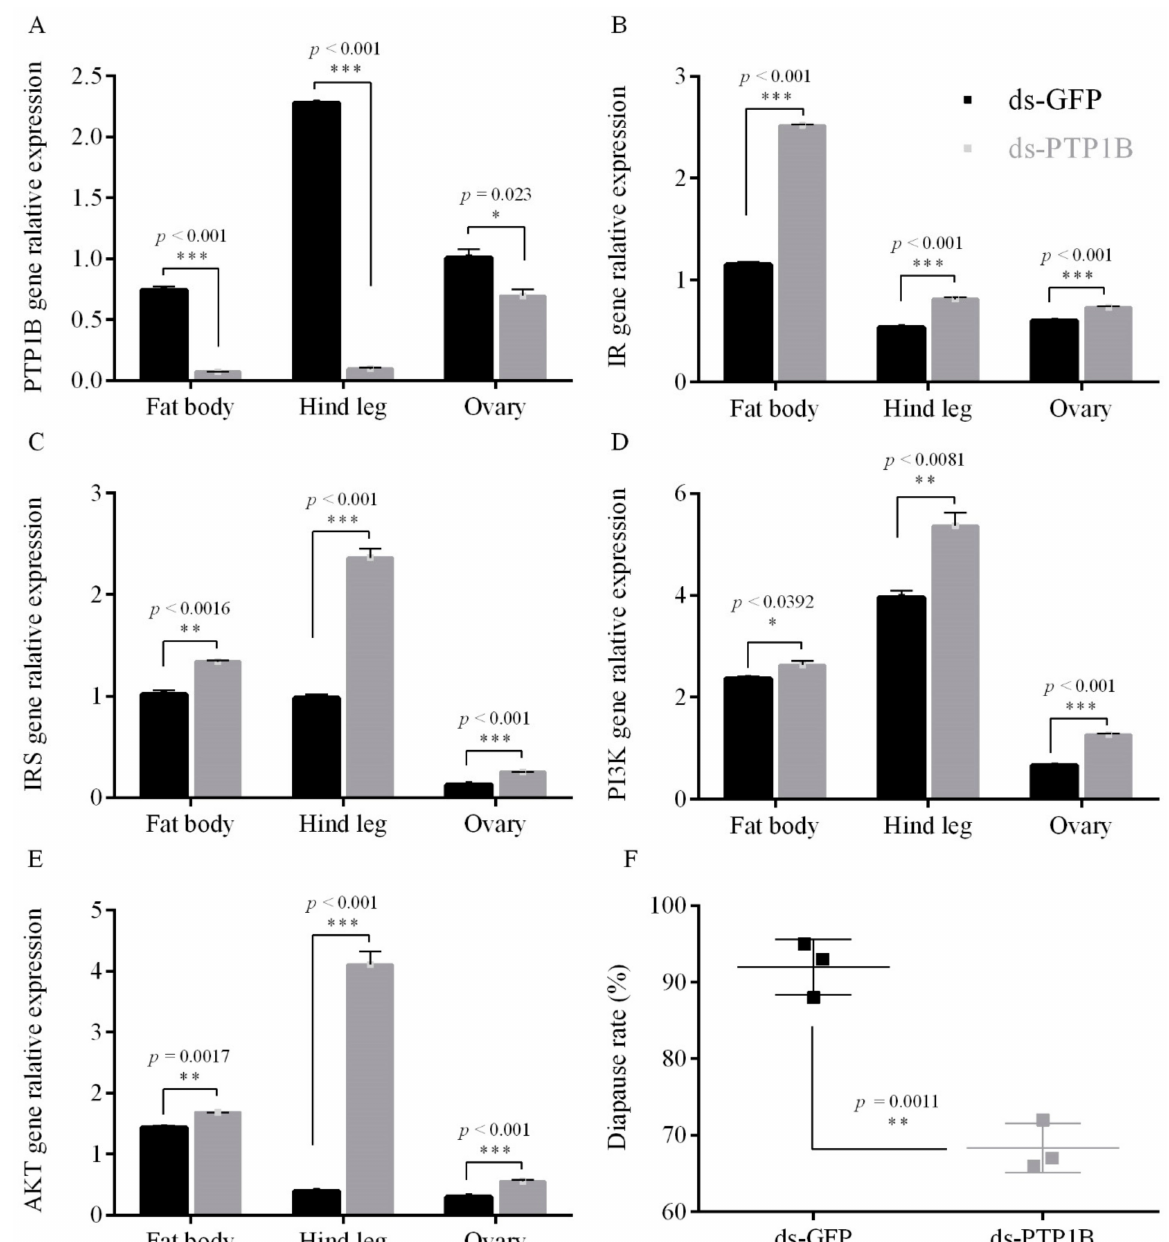
Figure 1. Gene relative expression and egg diapause incidence after injection of adults with RNAi PTP1B compared to injection with GFP (control) under short photoperiod conditions (L10: D14) for ( A ) PTP1B gene, ( B ) IR gene, ( C ) IRS gene, ( D ) PI3K gene, ( E ) AKT gene and ( F ) egg diapause incidence. Data are the mean ± SEM from three independent replicates, the gray bar indicates RNAi treatments, while the black bar indicates GFP controls (* p < 0.05, ** p < 0.01, and *** p < 0.001 vs. GFP controls, Student’s t